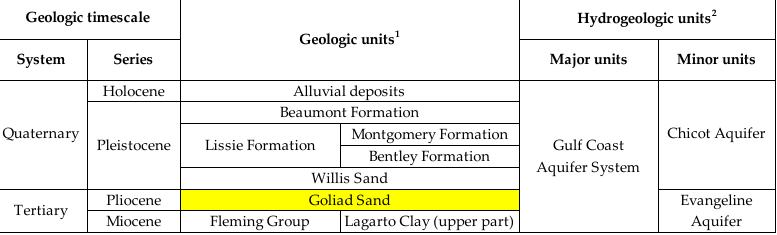
Figure 4. A generalized geologic stratigraphic column of the study area in the Texas Coastal Plain including the Goliad Sand, which is the host for uranium roll-front type deposits mined by the sixed ISR operations in this study. 1 Modified from [34,35,38,39] . 2 Modified from [34,35,40,41] .